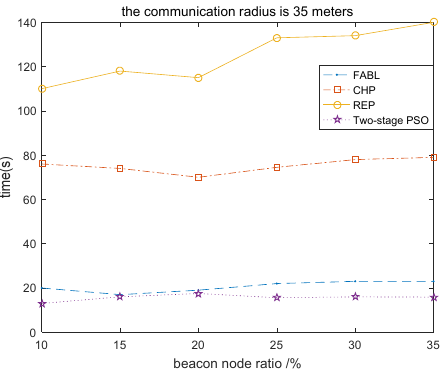
Figure 8. Relationship between beacon node ratio and execution time of algorithm.